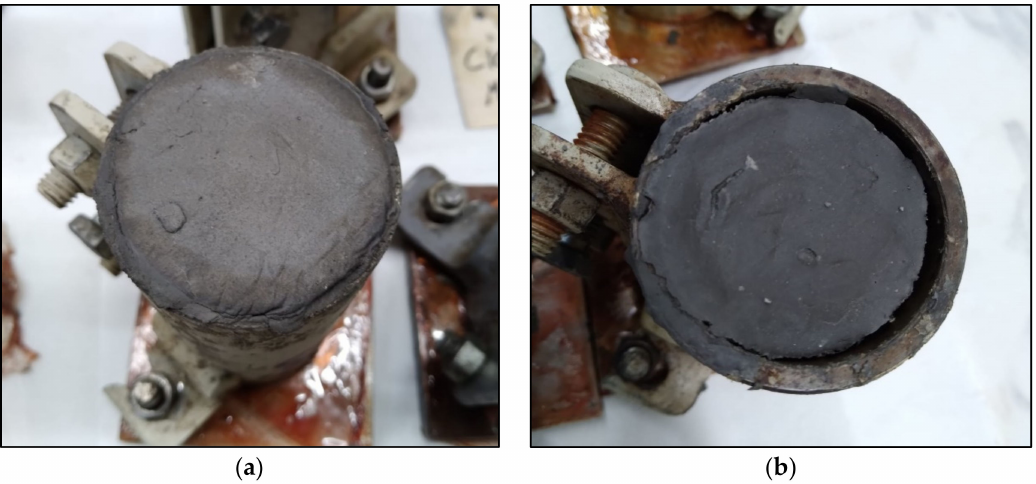
Figure 8. Volumetric shrinkage observed in hardened geopolymers: mixture activated with ( a ) sodium hydroxide and ( b ) sodium silicate.